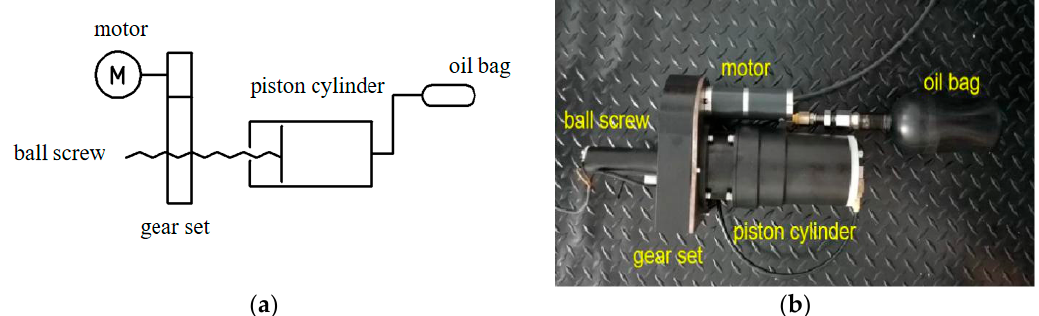
Figure 8. ( a ) Schematic diagram of the buoyancy adjustment system; ( b ) picture of the buoyancy adjustment